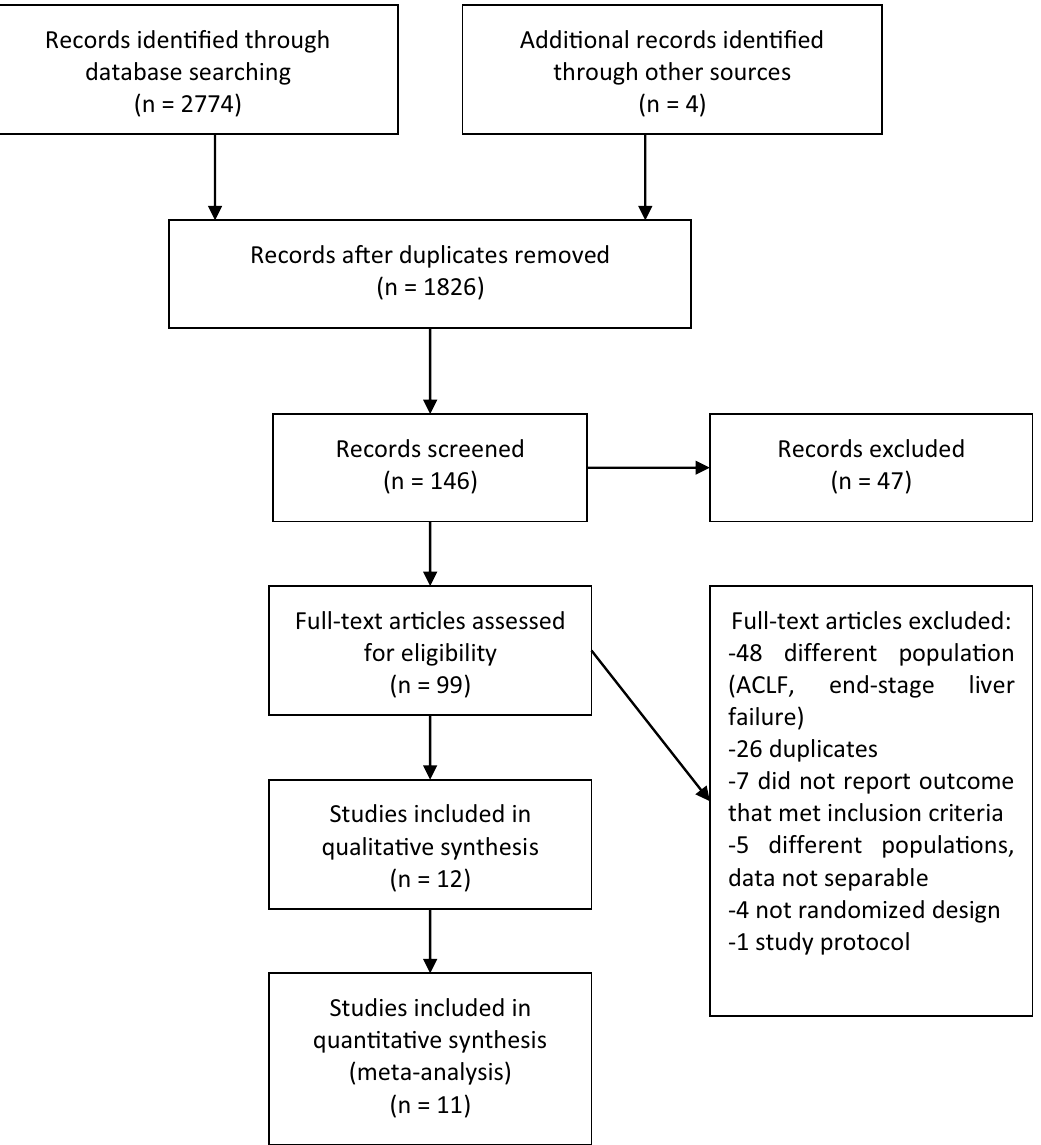
Figure 1. Study selection process. PRISMA flowchart containing results of systematic search and article selection. ACLF, acute-on-chronic liver